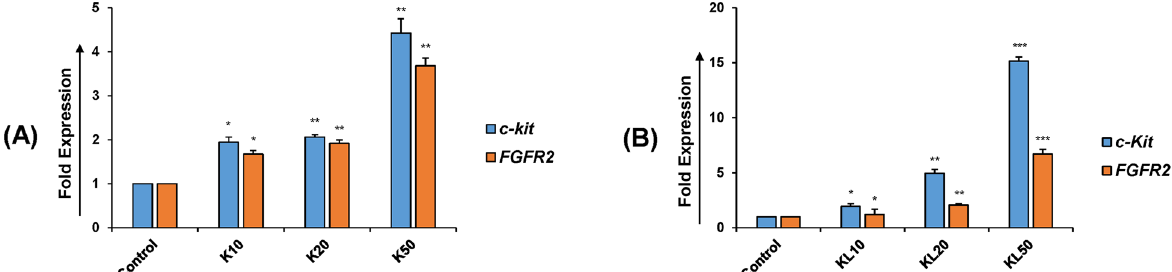
Fig. 4 Autocrine action of KGF and KITLG in buffalo granulosa cells. A A significant increase was observed for c-kit and FGFR2 expression in a dose-dependent manner of KGF treated cells. B The KITLG treated cells resulted in upregulation of c-kit (by > 10 folds) and FGFR2 (by > 5 folds) ( B ). These observations suggest that KGF and KITLG act synergistically by regulating each other’s expression across their site of production and action. K represents the KGF, KITLG is denoted by KL. The dose concentrations are defined as 10, 20, and 50 ng/ml for both KGF and KITLG. Values are expressed as the mean SD of three experiments; * P < 0.05, ** P < 0.01, *** P < 0.001 vs. the control ±